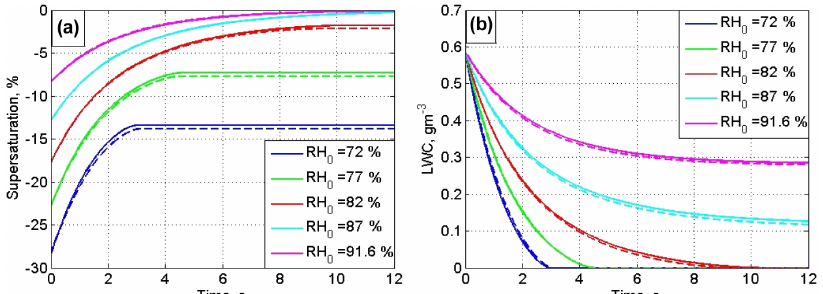
Figure 3. Dependencies S(t) (a) and q w (t) (b) , calculated at different initial relative humidity RH 0 using closed differential Eqs. (12) and (13) (solid lines) and using a parcel model (dashed lines). The calculation parameters are T m0 = 10 ◦ C, p 0 = 842mb, r 0 = 10µm, N m0 = 140cm − 3 , q w0 = 0 . 58gm − 3